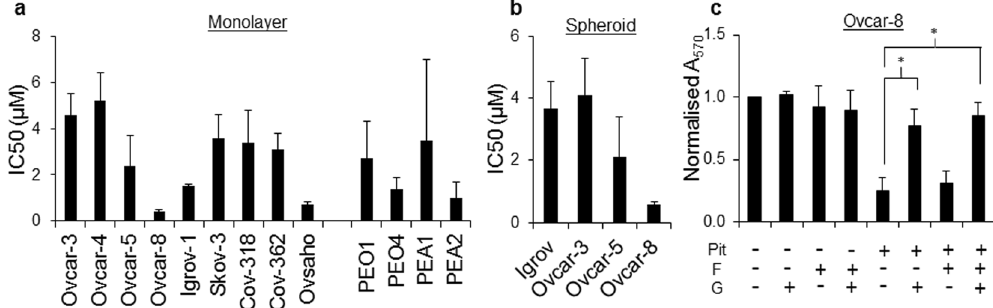
Figure 2. Pitavastatin inhibits the growth of cultures of ovarian cancer cells. The effect of pitavastatin was assessed in cell growth assays (mean IC 50 ± S.D., n = 3–5 biological replicates) using monolayer ( a ) and spheroid cultures ( b ). ( c ) The growth inhibitory effects of pitavastatin (1 μ M) on Ovcar-8 monolayer cultures were suppressed ( * paired t -test, P < 0.01) by geranylgeraniol (G, 10 μ M) but not farnesol (F, 10 μ